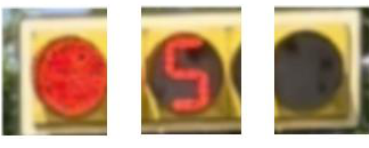
Figure 9. Results of image processing.